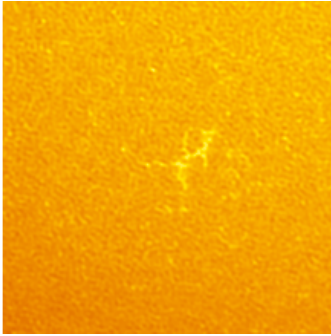
Figure 13. Active Region seen in H-Alpha